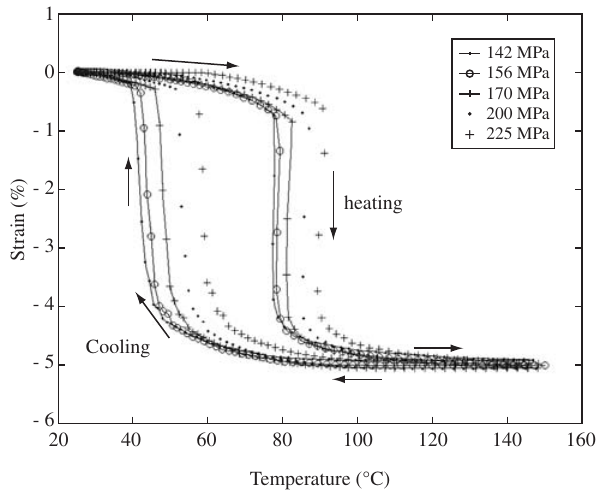
Figure 6. ε - T hysteresis loops for some applied loads on the SMA wire.